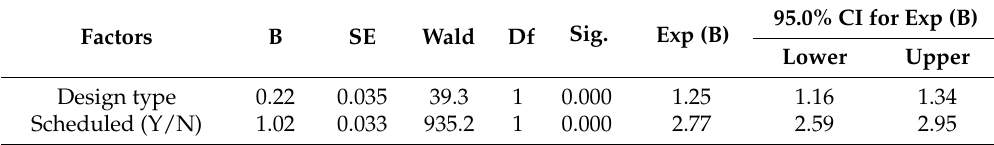
Table 6. Cox regression results for the factors that satisfy the proportionality